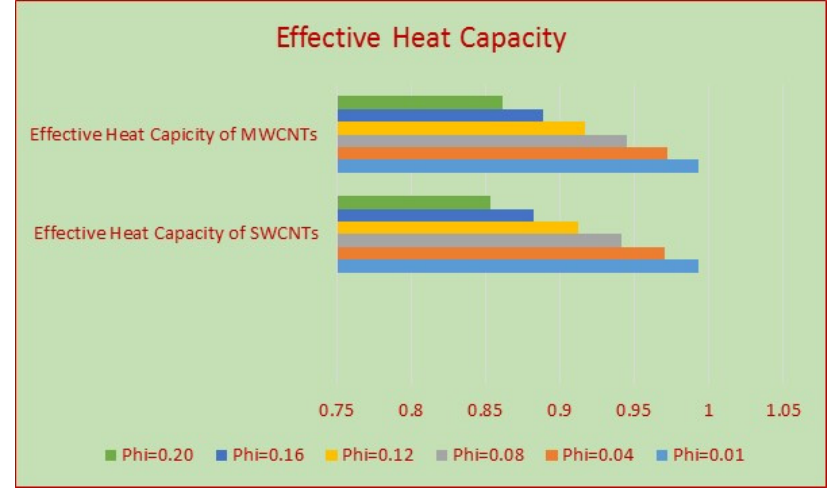
Figure 9. The behavior of heat capacity of SWCNTs and MWCNTs for multiple volume fraction factor φ .